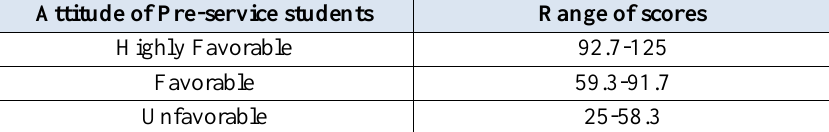
Table 4. Range of scores obtained on Attitude Scale